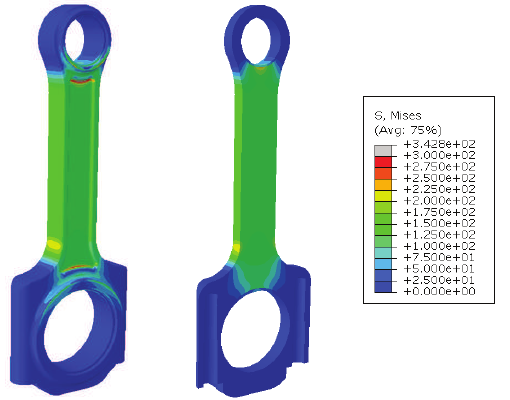
Fig. 8. Results of simulation of connecting rod model 12